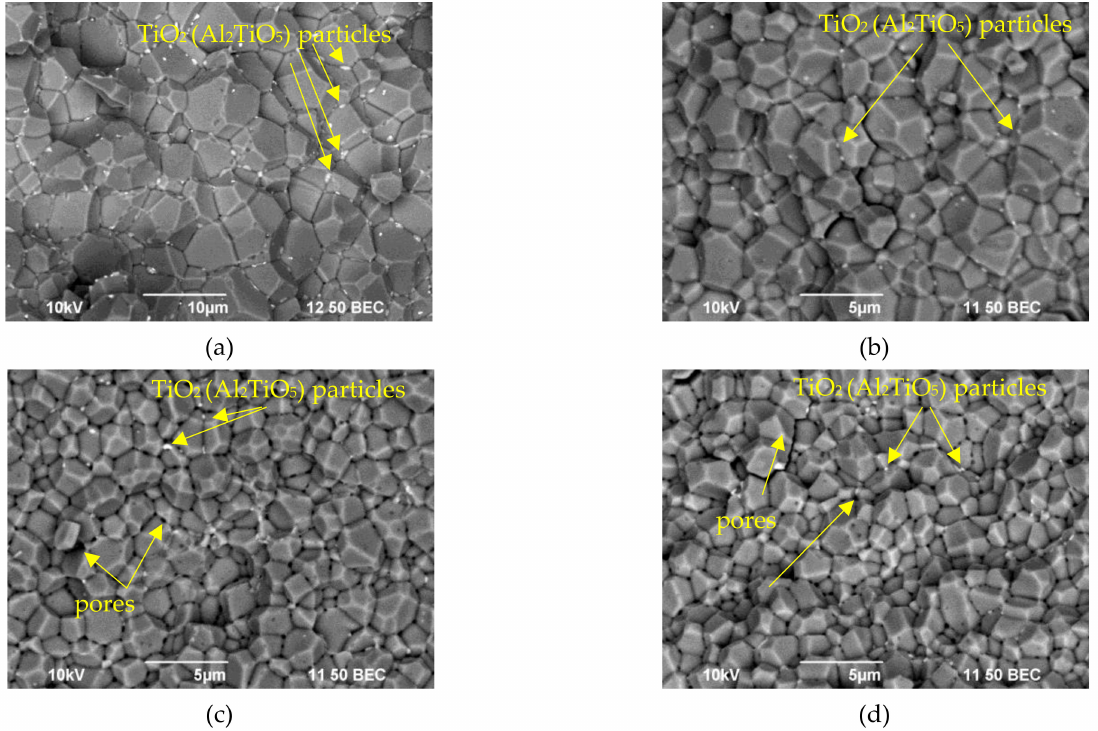
Figure A3. Fracture surfaces of α -Al 2 O 3 + 0.5%vol. TiO 2 samples obtained at Т = 1520 ◦ C at: ( a ) 10 ◦ C/min, ( b ) 100 ◦ C/min, ( c ) 350 ◦ C/min, ( d ) 700 ◦ C/min. Gray grains are Al 2 O 3 , white particles are TiO 2 (Al 2 TiO 5 ).